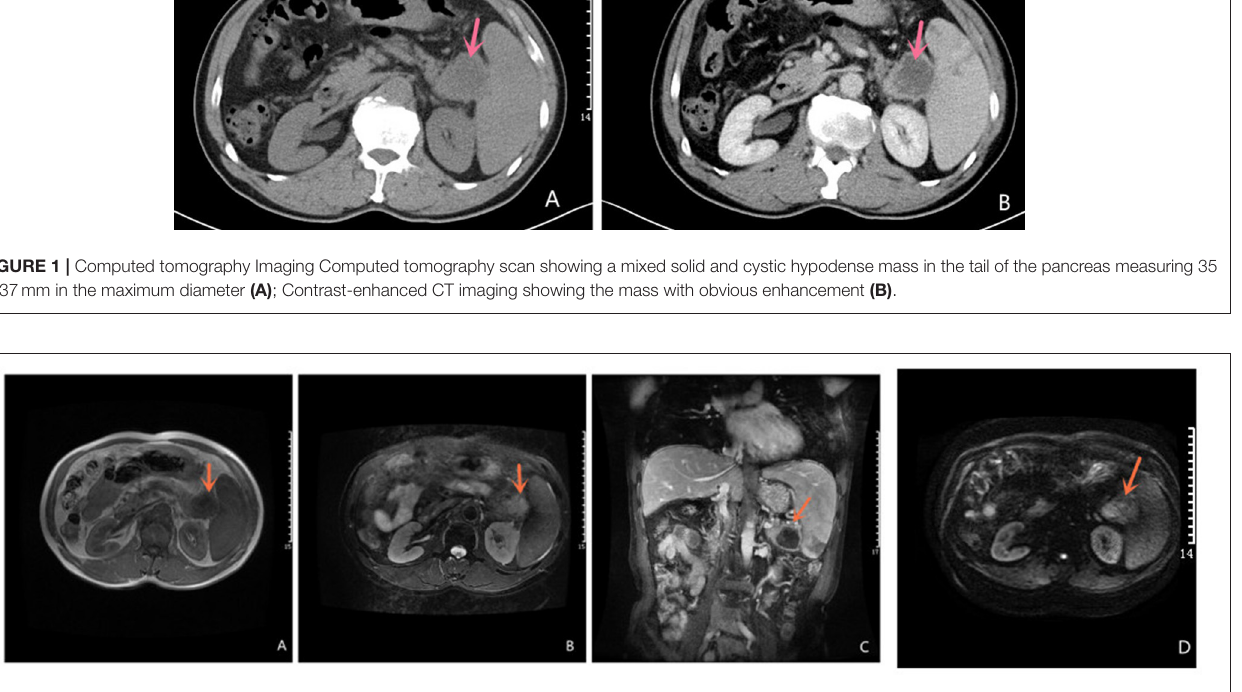
FIGURE 2 | Magnetic Resonance Imaging Magnetic Resonance of abdominal revealed a mass in the tail of the pancreas. T1-weighted images is low signal (A) and T2 -weighted images is high signal (B) ; Contrast-enhanced spin-echo T1-weighted MRI showed the lesion obvious enhancement (C) ; The tumor showed restricted diffusion on Diffusion-Weighted imaging (D) .